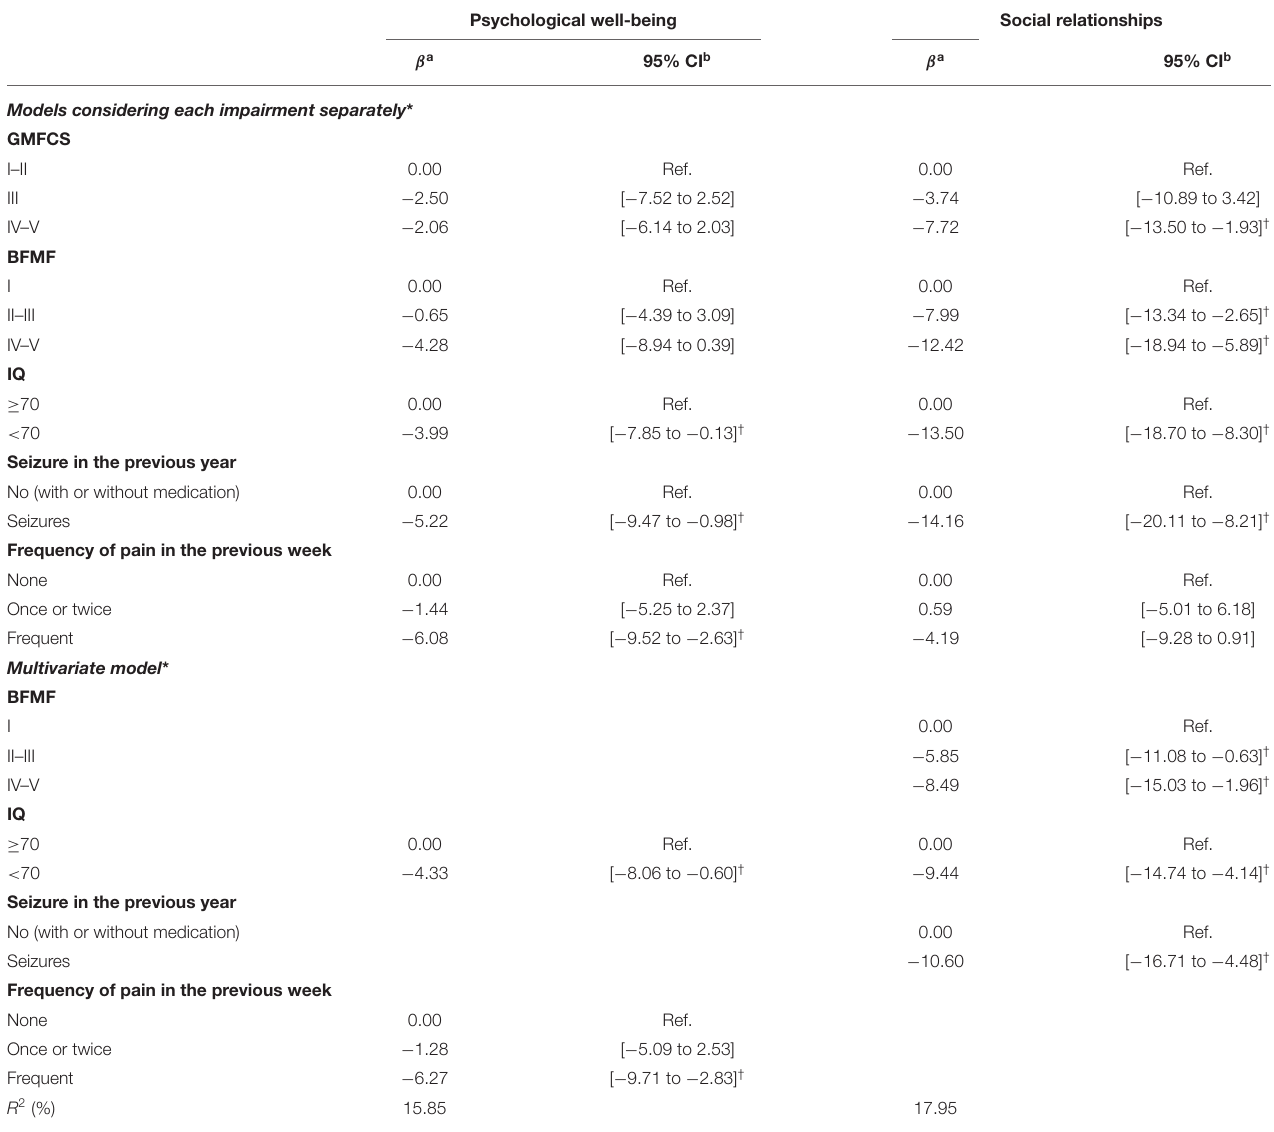
TABLE 4 | Average variations (by 1 year of age) in QoL by impairment severity, pain, and seizure problems in individuals with CP: SPARCLE cohort—France, Germany, Italy, and